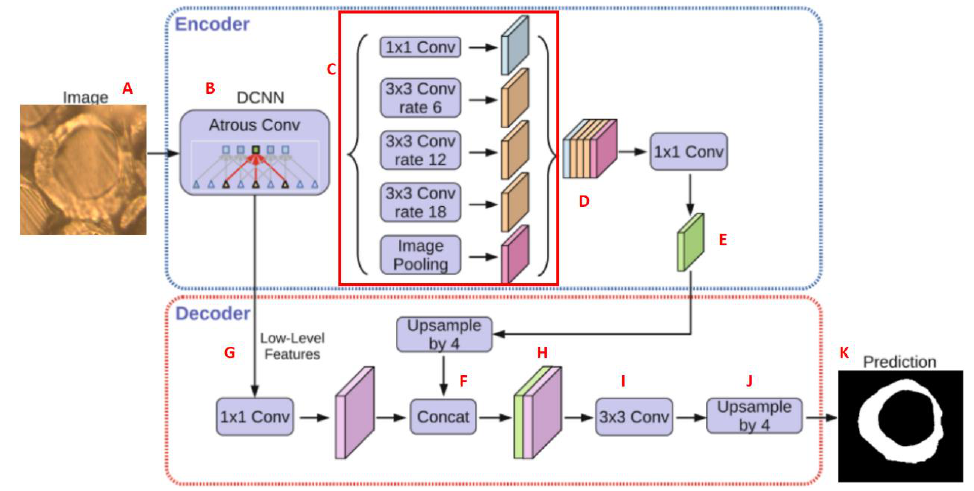
Figure 7. Establishment of DeepLabV3+ model.